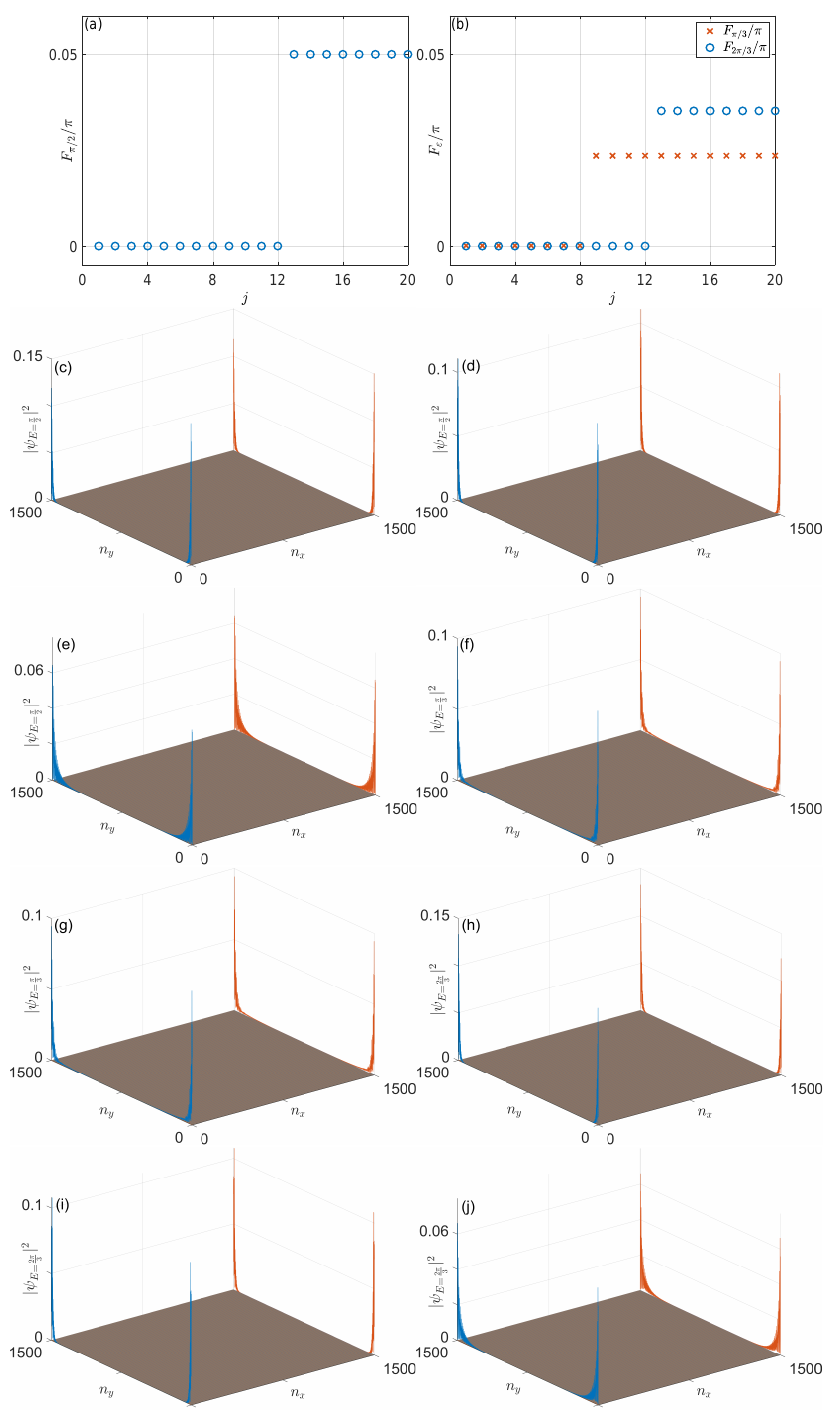
Figure 7: Gap functions and probability distributions of corner modes for U (a), (c)–(e) and for U in (b), (f)–(j). j and n are state and unit cell in- x , y 1 / 3 dices. System parameters are ( J , J , ∆ , µ ) = ( 2.5 π ,3 π ,0.05 π ,2 i ) . The lattice size is 1 2 = L = 3000. (a) and (b) show the gap function F L (cid:34) , which is zoomed in around x y F (cid:34) = 0 for (cid:34) = π/ 2, π/ 3 and 2 π/ 3. (c)–(e) show the twelve corner modes of U = 0). (f), (g) show the eight corner modes of U the quasienergy π/ 2 (with F π/ 2 = 0). (h)–(j) show the twelve corner modes of U the quasienergy π/ 3 (with F π/ 3 = at the quasienergy 2 π/ 3 (with F 2 π/ 3